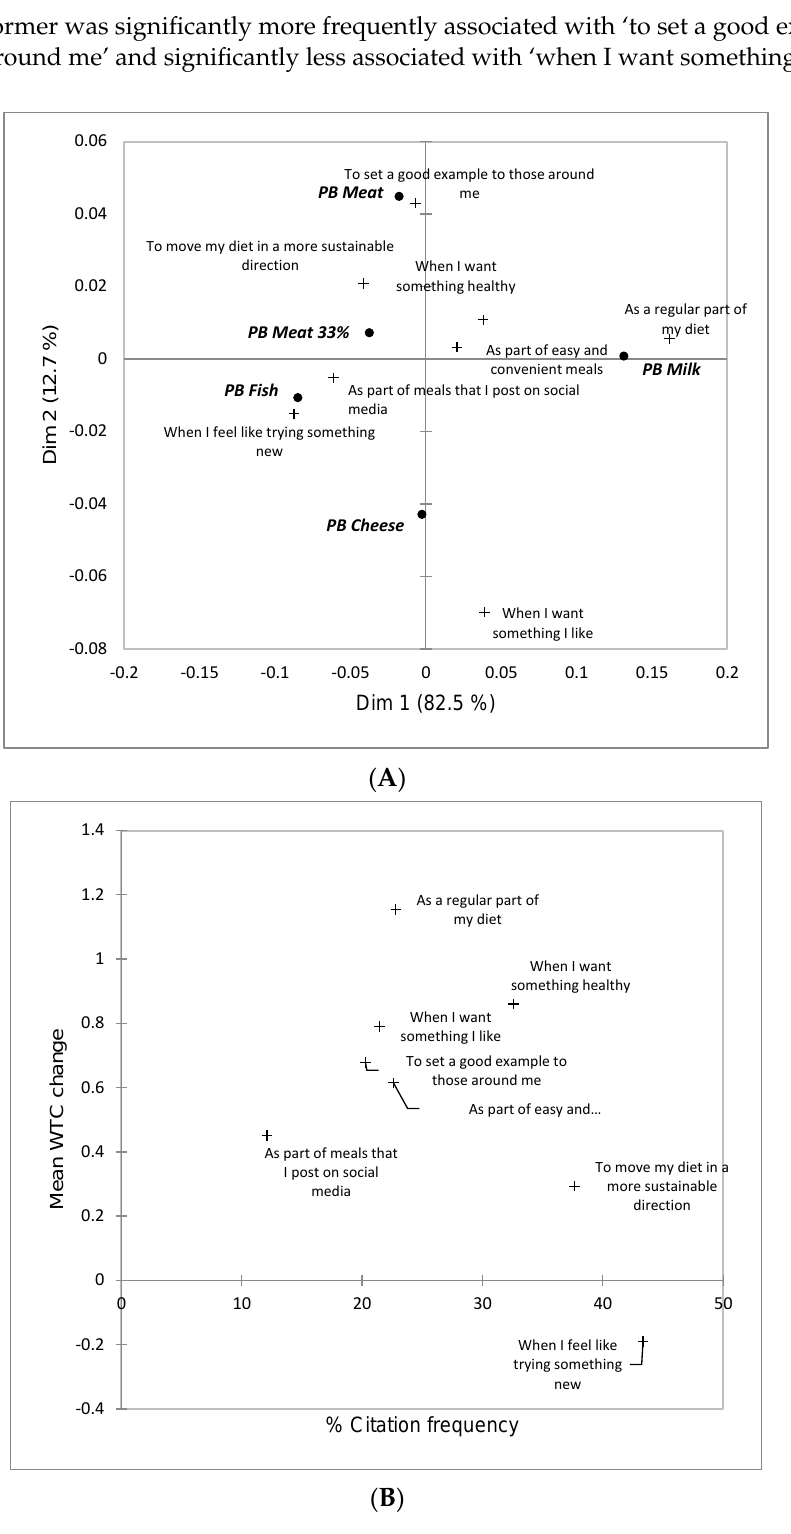
Figure 3. Results linked to situational use product associations for aggregate sample across 2494 consumers in USA, Australia, Singapore and India shown for the five plant-based (PB) food categories included in the research. ( A ) Plot of the first two dimensions following Correspondence Analysis; ( B ) Impact on average willingness to consume (WTC) based on Penalty/Lift analysis. In ( A ), PB food categories are shown in bold and italic font. In ( B ), change in WTC is significantly different from zero ( p < 0.05) for all terms.